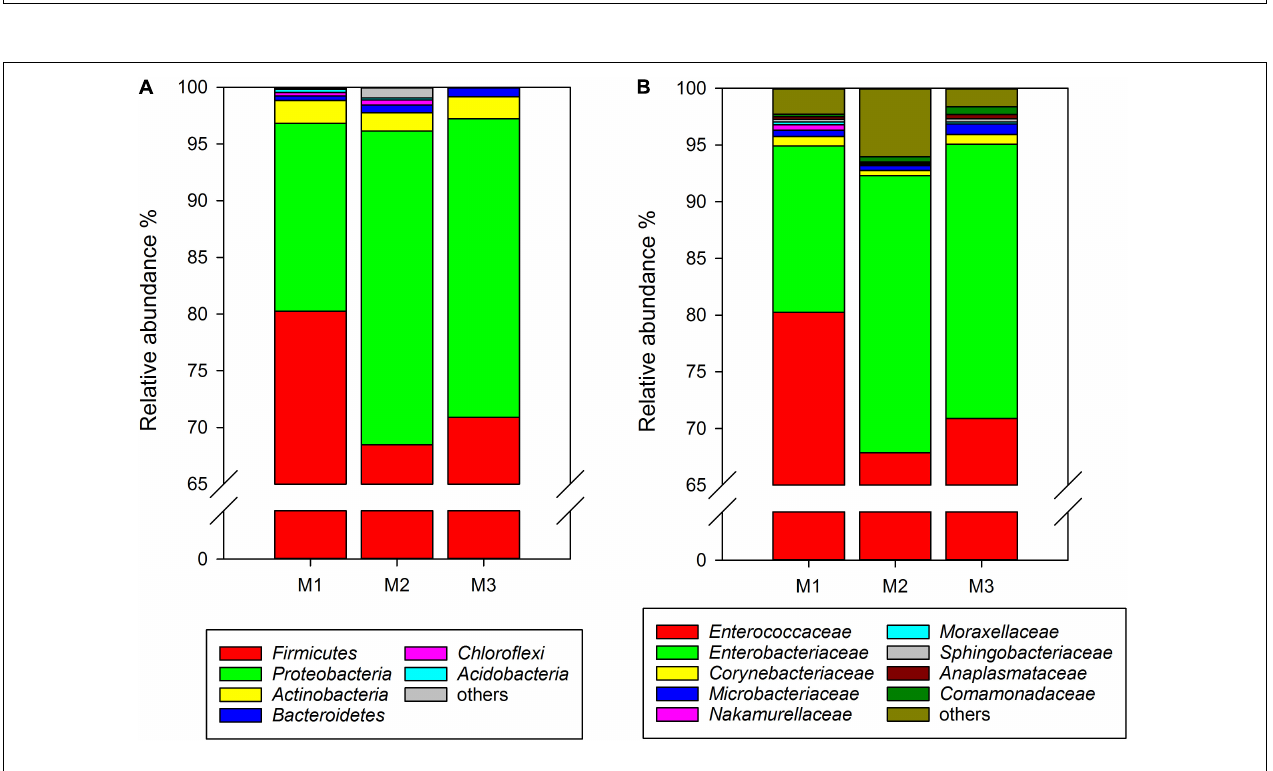
Frontiers in Microbiology |